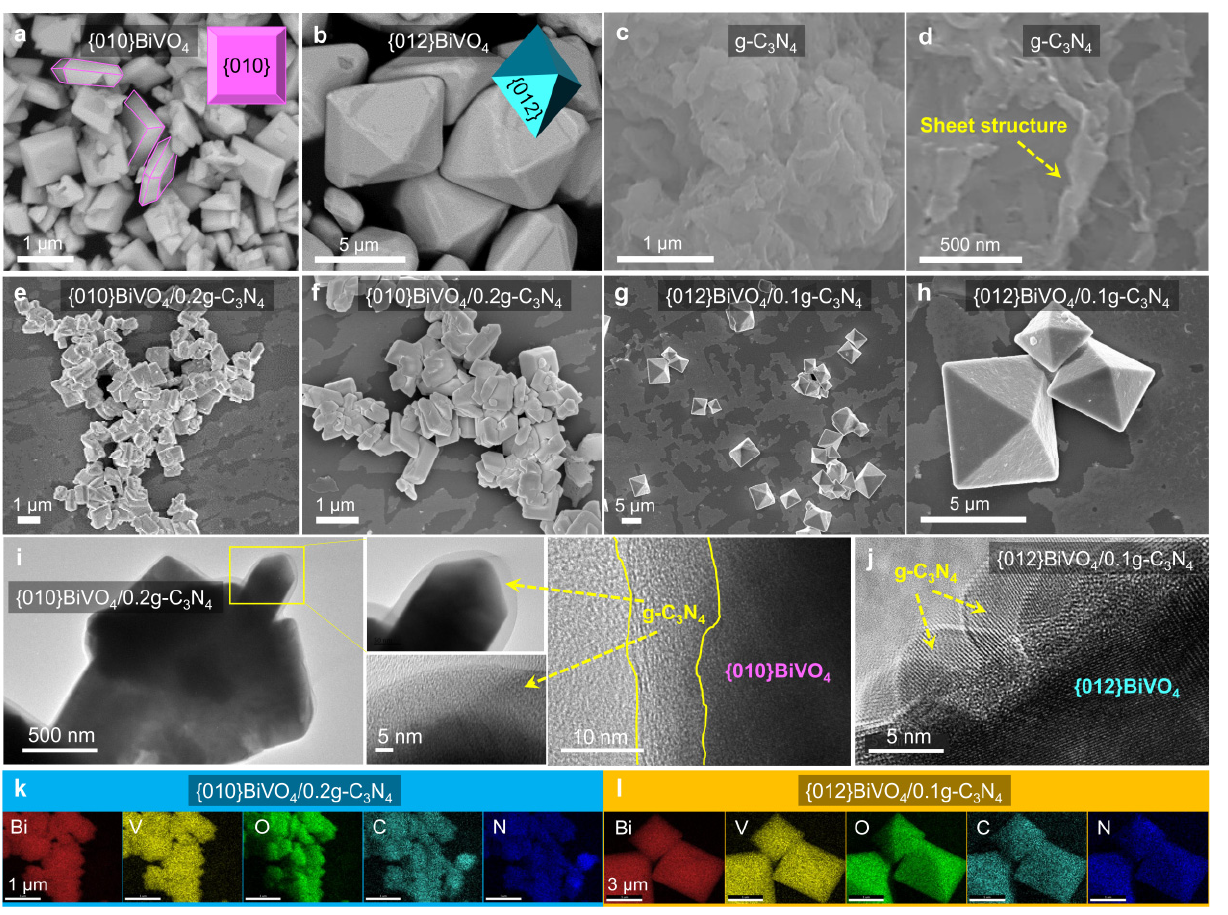
Figure 1. ( a ) SEM images of {010}BiVO 4 , ( b ) {012}BiVO 4 , ( c , d ) g-C 3 N 4 , ( e , f ) {010}BiVO 4 /0.2g-C 3 N 4 , and ( g , h ) {012}BiVO 4 /0.1g-C 3 N 4 . ( i ) TEM images of {010}BiVO 4 /0.2g-C 3 N 4 and ( j ) {012}BiVO 4 /0.1g-C 3 N 4 . ( k ) SEM mapping images of {010}BiVO 4 /0.2g-C 3 N 4 and ( l ) {012}BiVO 4 /0.1g-C 3 N 4 .